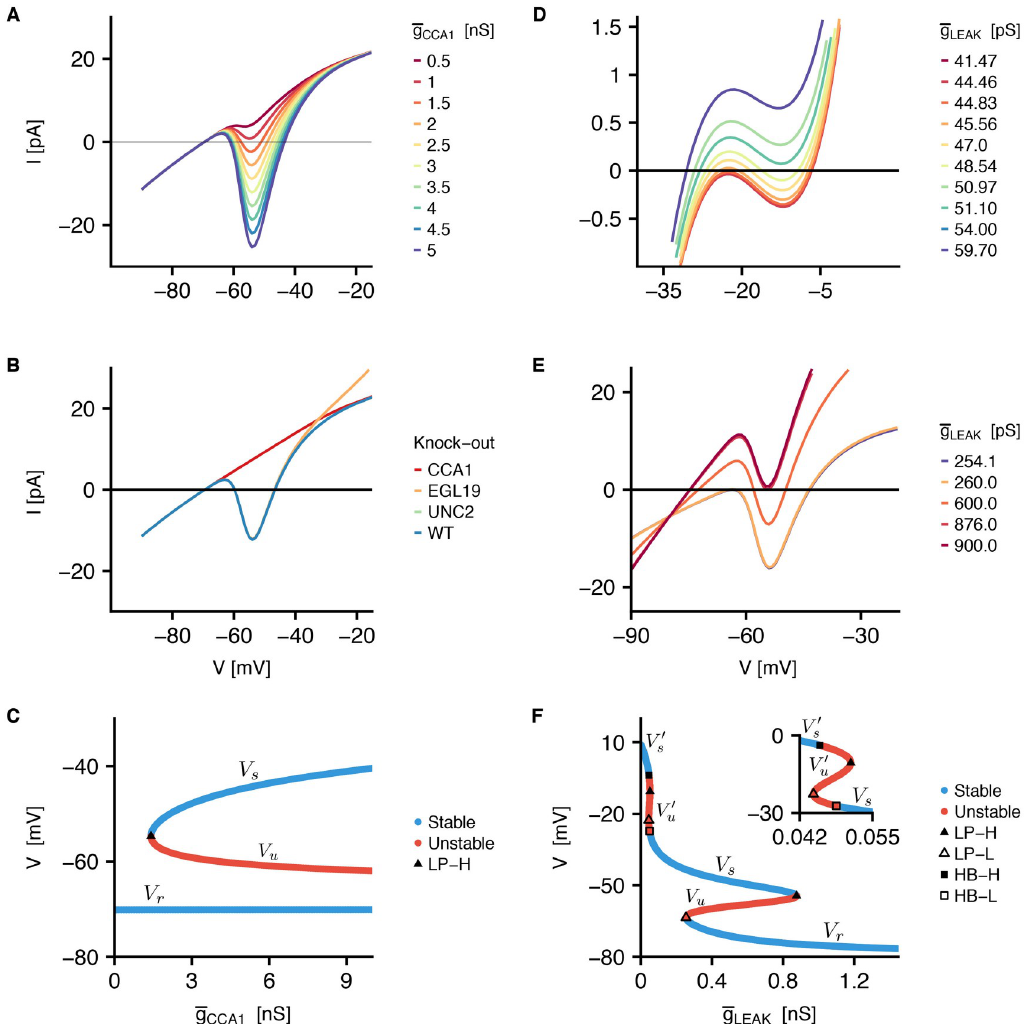
Fig 10. Analysis of the bistable behavior of RMD neuron. A) Steady-state I-V curves at varying � g . Steady-state I-V curves CCA 1 are obtained from the currents computed during a voltage clamp stimulation with steps ranging between -90 mV and -10 mV, with 1 mV increments. The value of � g is varied between 0.5 nS and 5 nS with 0.5 nS increments. B) Calcium channels CCA 1 knockouts steady-state I-V curves . Voltage clamp simulation follows the same protocol of panel A. Knockout I-V curves are computed by removing the contribution of one of the CaV from the total current, leaving unchanged the other conductances. C) Bifurcation diagram with � g as bifurcation parameter . The black empty triangle represents the saddle-node (or limit point CCA 1 LP-H) bifurcation point [V, � g ] = [-59.5 mV, 1.14 nS]. At � g > 1 : 14 nS the system exhibits three fixed points: two stable CCA 1 CCA 1 ( V and V ) and one unstable ( V ). D)-E) Steady-state I-V curves for different values of � g . The passive conductance is r s u LEAK varied between 0.04 nS and 0.9 nS to obtain the steady-state I-V curve in correspondence of the different regimes highlighted also by the bifurcation diagram analysis (panel F). The applied voltage stimuli ranges from -90 mV to -30 mV with 0.8 mV increments, in panel D, and from -35 mV to +5 mV with 0.8 mV increments, in panel E. Step duration 1300 ms, holding potential V = − 70 mV. F) Bifurcation diagram with � g as bifurcation parameter . For 0.25 nS < � g < 0 : 9 nS two stable h LEAK LEAK solutions are separated by an unstable one. These correspond to V r , V s and V s in panel C. At lower values of � g , and by LEAK decreasing the parameter, two unstable solutions V 0 and V 0 arise from a LP bifurcation (LP-H), with V � V 0 � V 0 . By s u s u s gains stability through a subcritical Hopf bifurcation (HB-H), while at lower values of the decreasing the control parameter, V 0 s control parameter, V s loses stability through a second subcritical Hopf bifurcation (HB-L). Finally, by further lowering the parameter, V 0 and V collide in a second fold bifurcation (LP-L) and V 0 remains the only stable solution at even lower values of s u s � g . A second bistable regime may occur in between the two Hopf LEAK